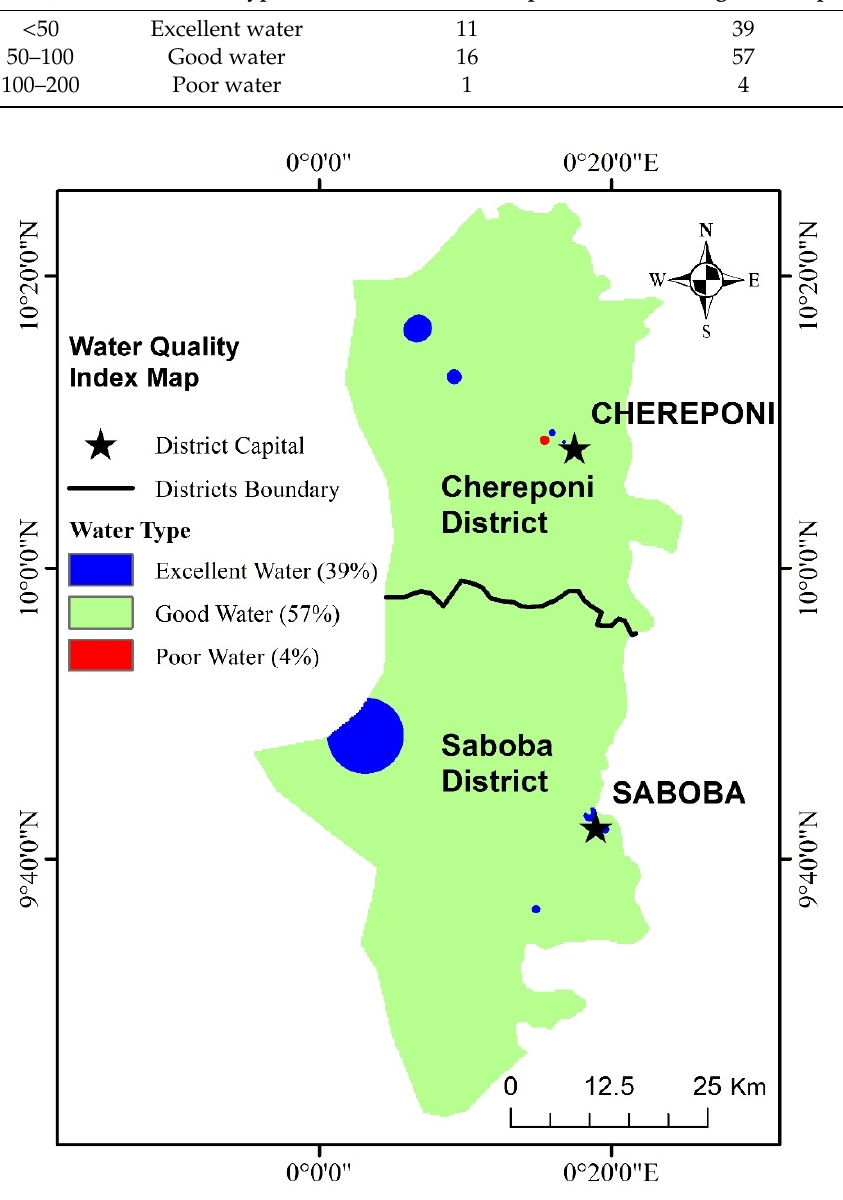
Figure 6. Water Quality Index Map.